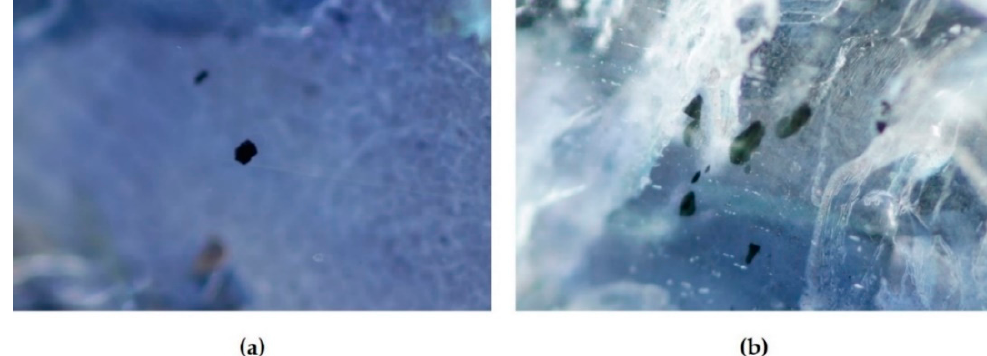
Figure 4. Photomicrographs taken with dark field illumination, magnified 50 × , showing rhombohedral ilmenite inclusions: ( a ) a single crystal (sample DL85 from Di Linh) as reported by Vu et al. [9] and ( b ) several single crystals (sample GL25 from Pleiku).